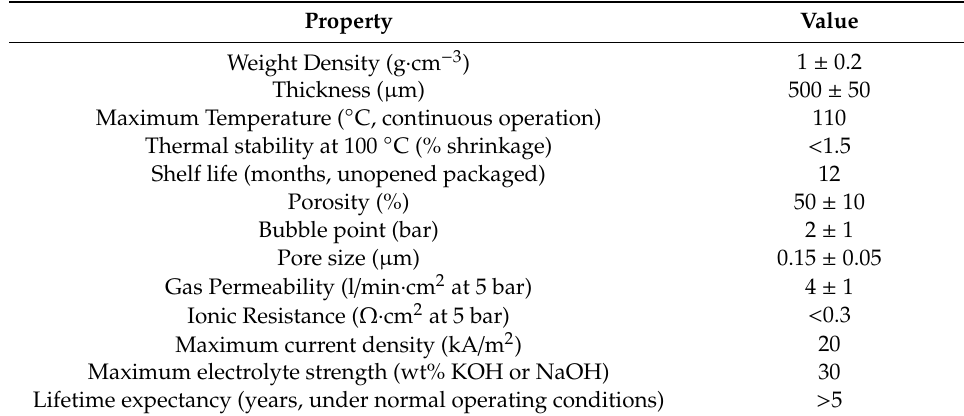
Table 1. Zirfon Perl UTP 500 ® mean features